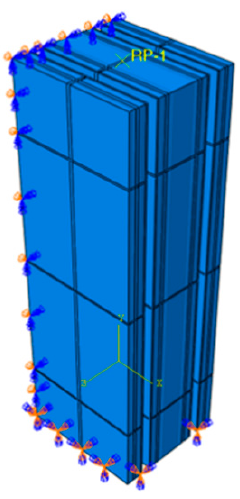
Figure 14. Shear finite element model (side).